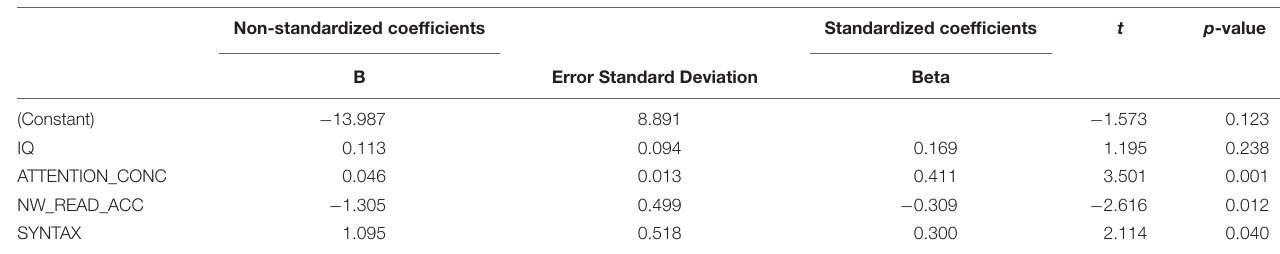
TABLE 3 | Coefficients of the regression equation for Version 2 total score (17